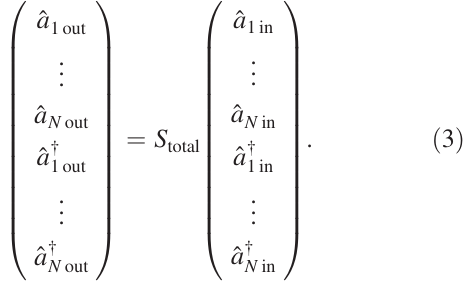
ffiffiffiffiffiffiffiffiffiffiffiffiffi p 1 − σ 2 representing the transmis-